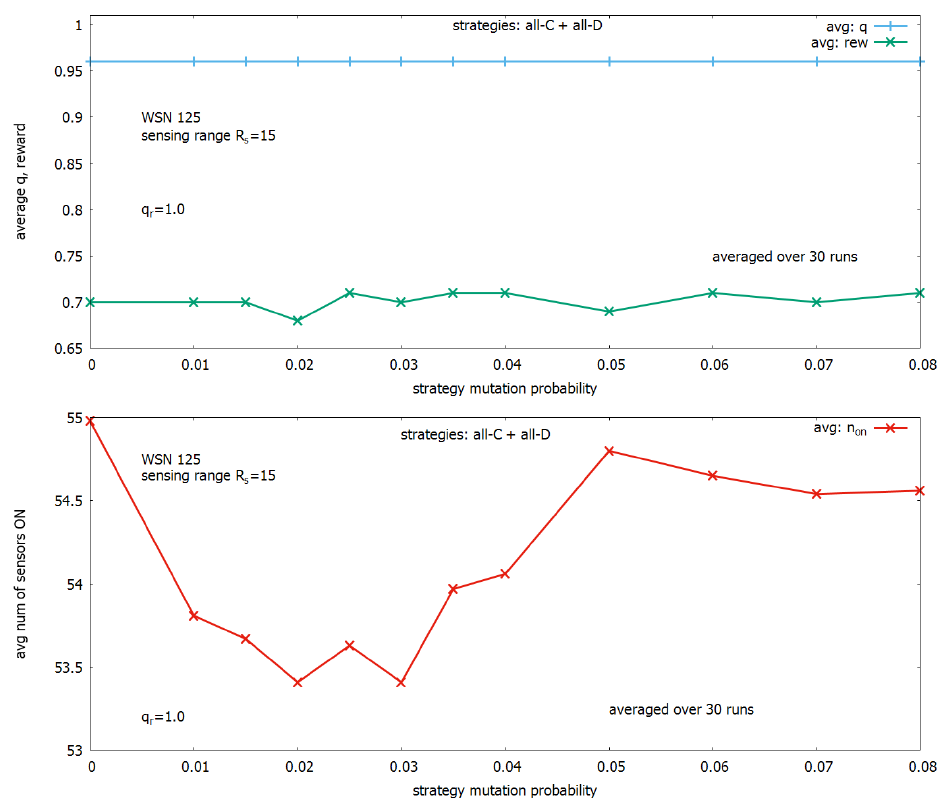
Figure 7. Searching for an optimal strategy mutation rate: influence of mutation rate on coverage q ( upper ), influence of mutation rate on a number of sensors turned on ( lower